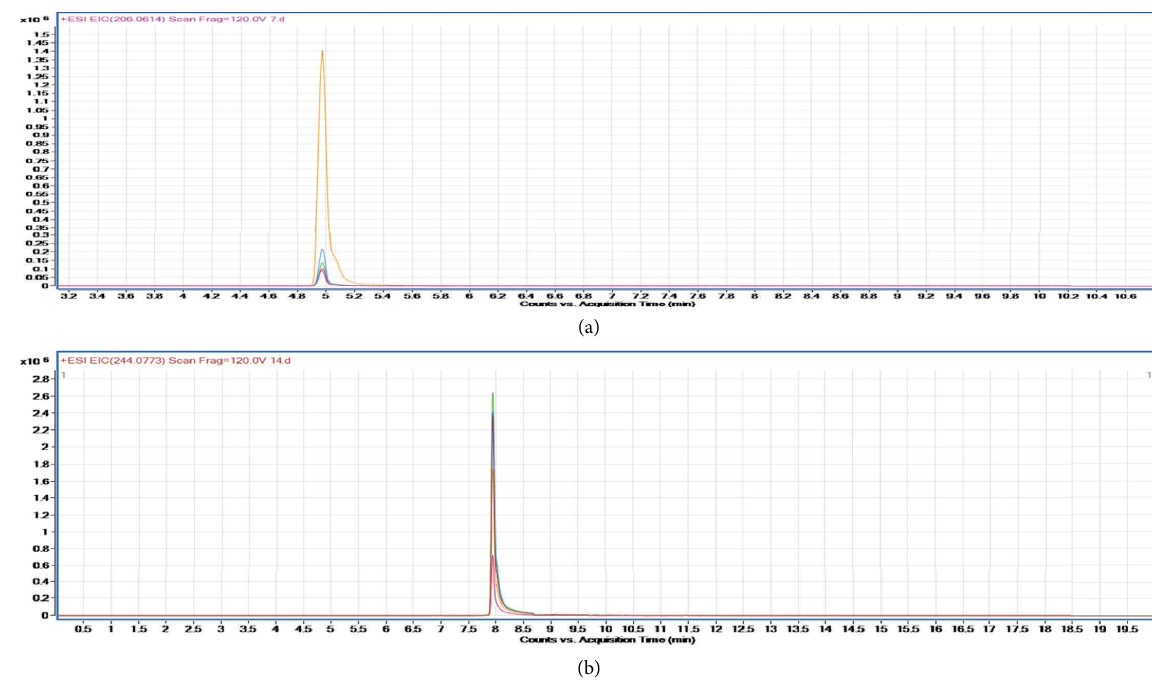
Figure 7: Chromatogram of metabolites m / z 207. (a) Chromatogram of metabolites m / z 247